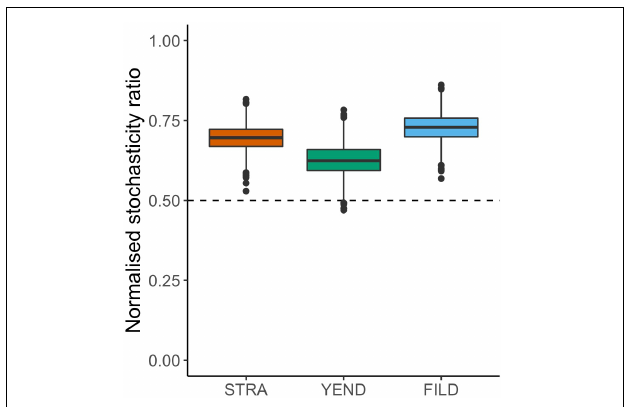
FIGURE 5 | Incidence-based normalised stochasticity ratio ( NST) : The index is bounded between zero and one, depicting fully deterministic or stochastic community assembly, respectively. The 50 % boundary between both extreme scenarios is shown. Similar results were obtained when using abundance-based beta diversity (Bray-Curtis, Supplementary Figure 2 ).